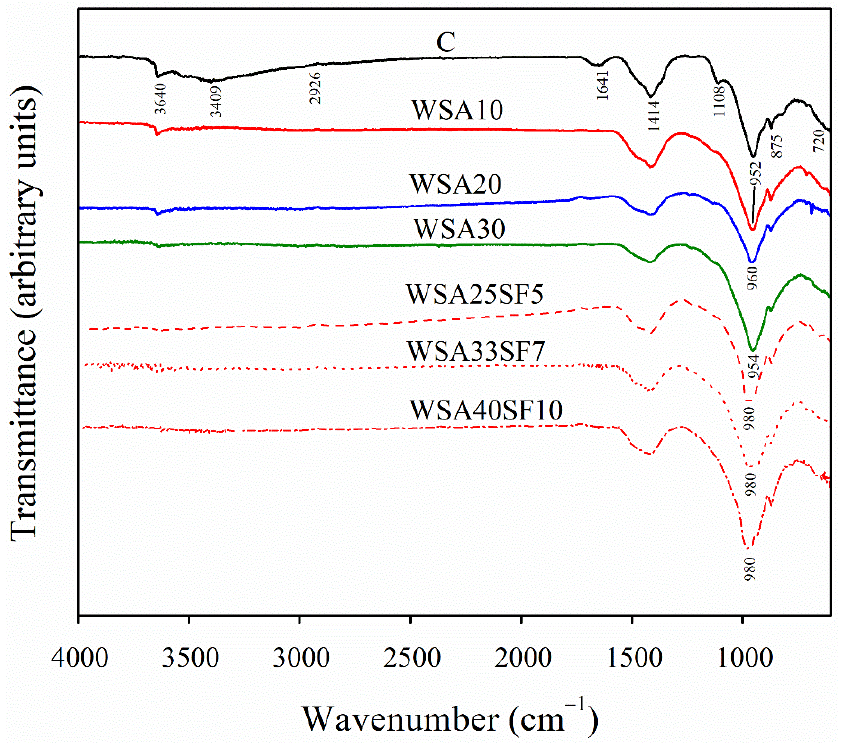
Figure 7. FTIR spectra of control, binary (C/WSA), and ternary (C/WSA/SF) paste samples after 91 days of curing.